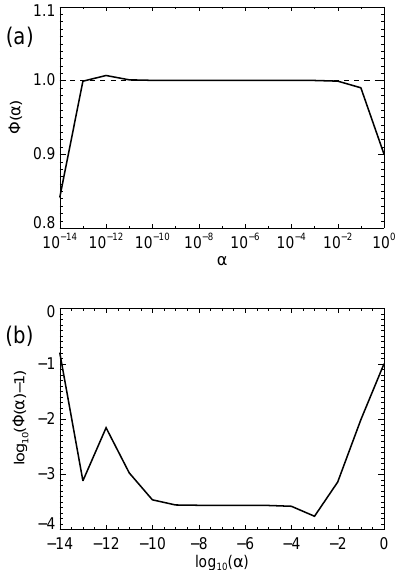
Figure 6. Verification of the alpha test. (a) variation of φ(α) with respect to α ; (b) variation of log 10 (φ(α) − 1 ) with respect to log 10 (α) . Figure 5. (a) Locations of grid cells from which tracer is released for 10 individual 1-month transport reciprocity tests described in Sect. 5. (b) Tracer mass (kg) at the seventh model level from the surface (approximately 2.6km) at the end of a 30-day forward simulation initialised with a mass of 100kg at the surface below the grid cell labelled “ S ” on 1 July 2008. The mass of tracer in the grid cell labelled “ D ” is 10 . 807 × 10 − 2 kg. (c) Surface tracer mass (kg) at the end of a 30-day adjoint simulation initialised with a mass of 100kg above grid cell labelled “ D ” on 31 July 2008. The tracer mass in “ S ” at the surface is also equal to 10 . 807 × 10 − 2 kg.